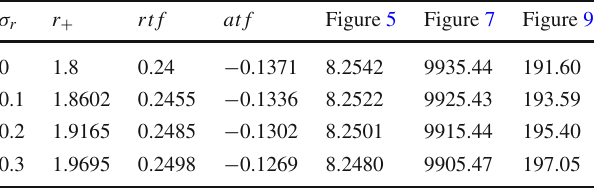
Table 3 Location of event horizon for chosen values of the radiation parameter